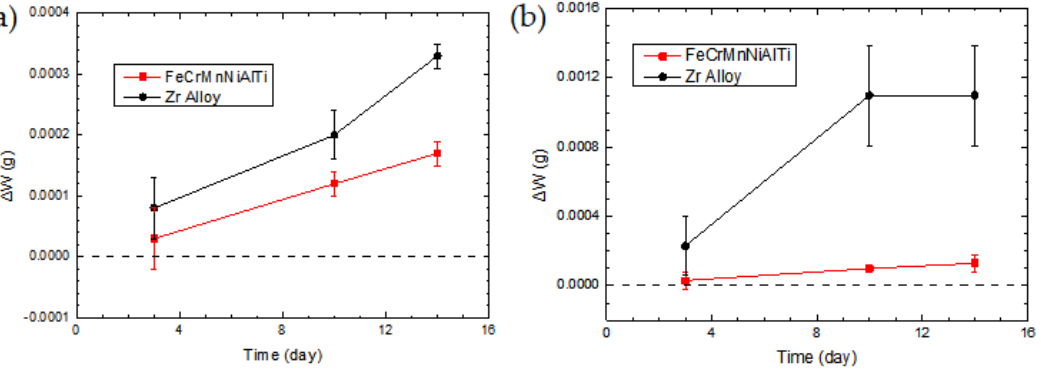
Figure 7. Corrosion weight loss curve of the (FeNi)67Cr15Mn10Al5Ti3 alloy and Zr-4 alloy: ( a ) 360 °C; ( b ) 400 °C.